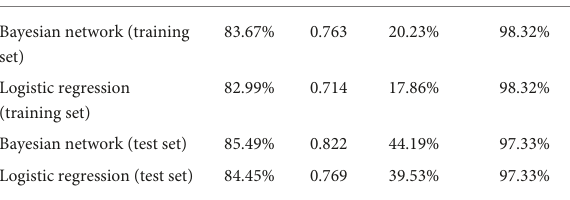
TABLE 4 The performance of different predictive